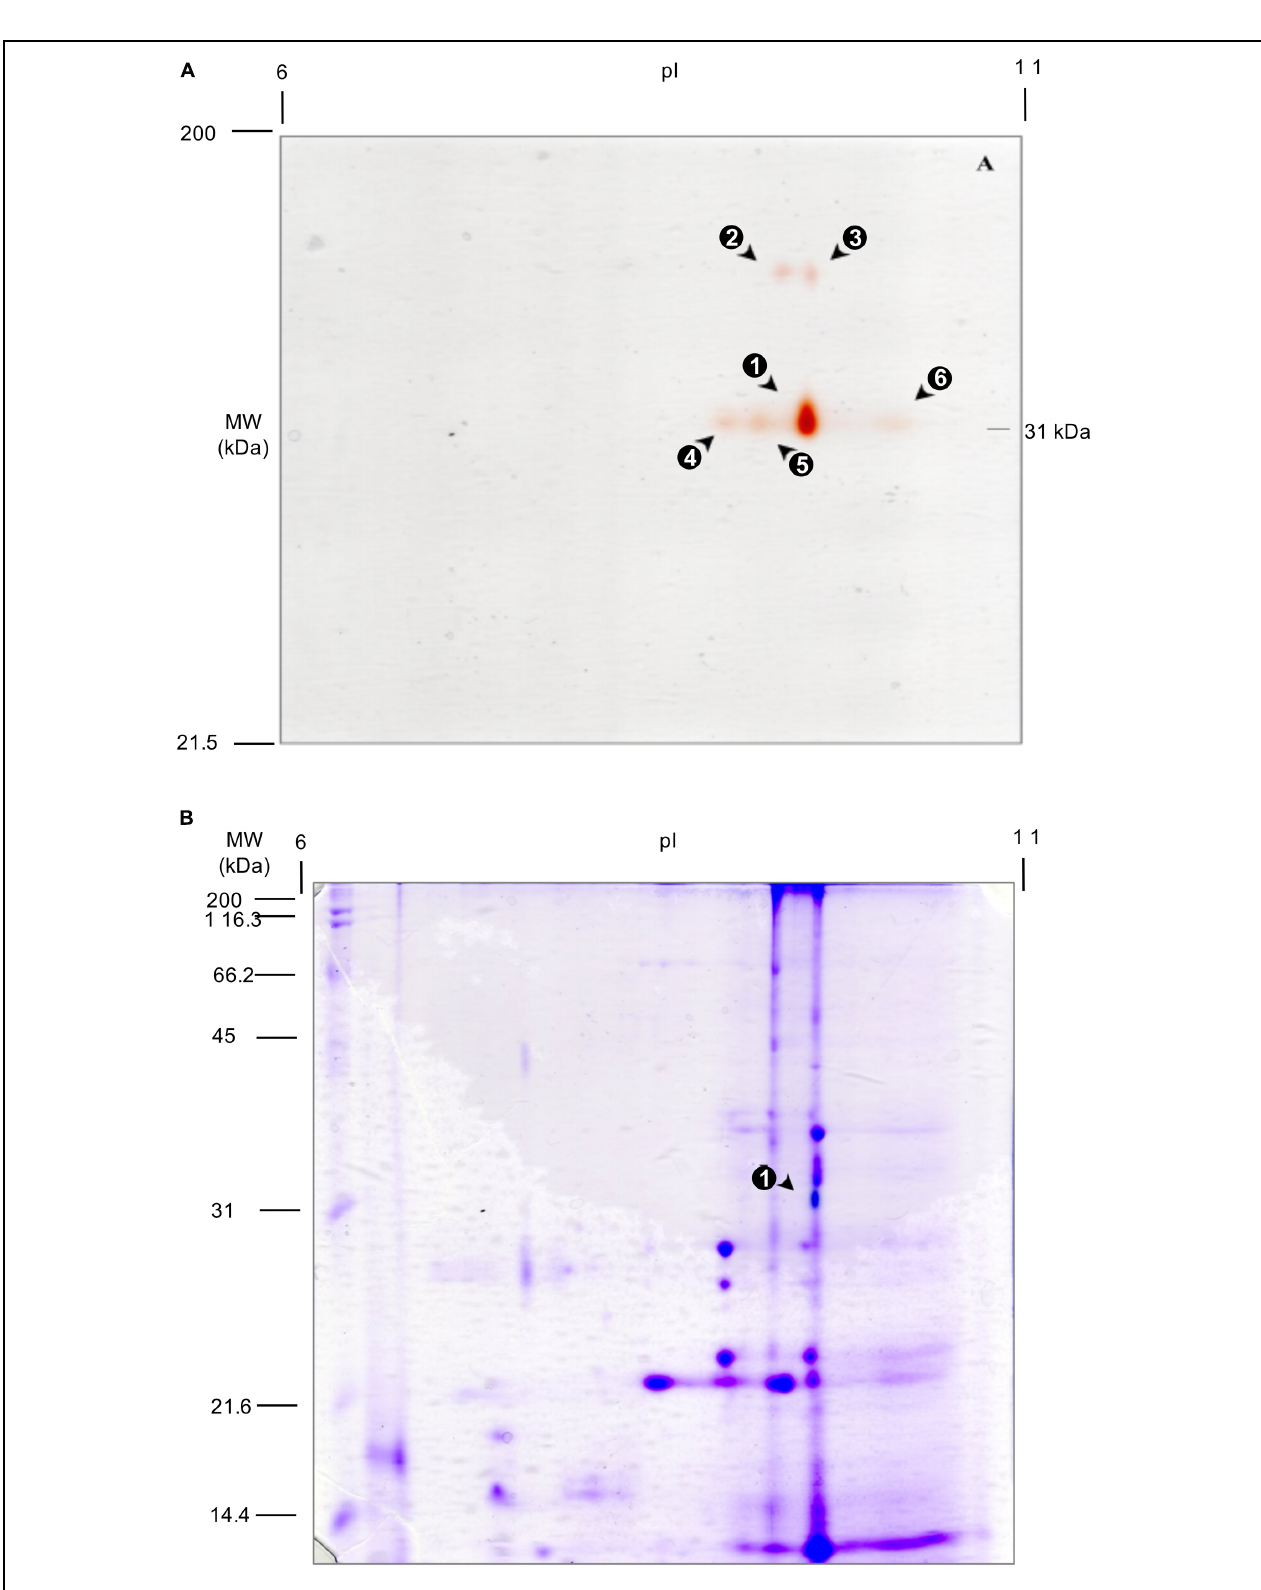
FIGURE 1 | 2D Analysis of peroxidase (POD) activity from p84C3 maize kernels. (A) Guaiacol-H 2 O 2 staining. (B) Sequential staining (guaiacol-H 2 O 2 + Coomassie R-250). Arrows point to the spots with POD activity.